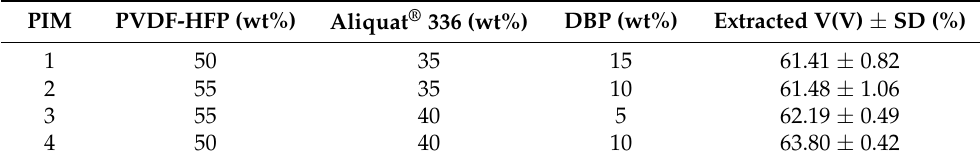
Table 1. Comparison of the extraction percentages of the successful PIMs. a PIM